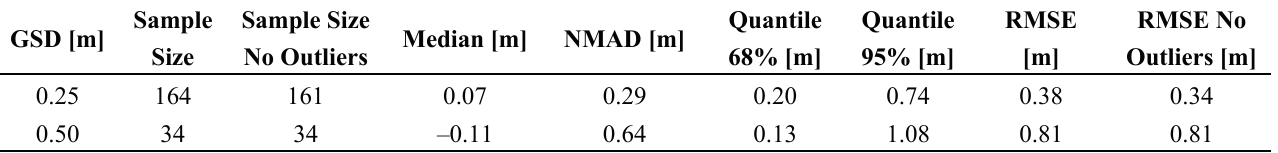
Table 3. Vertical accuracy measurements of the digital surface model based on 198 swisstopo topographic survey points. Differences were calculated by subtracting the elevation values of the topographic survey points from those from the digital surface